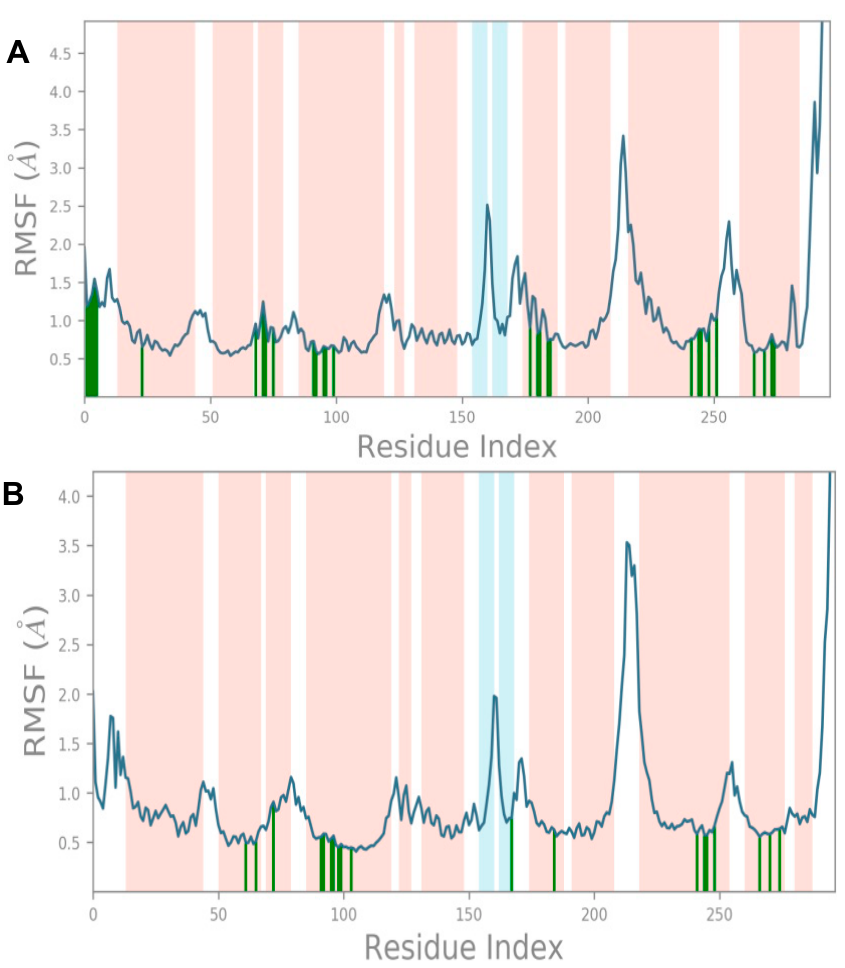
Figure 6. ( A ) The protein RMSF plot for etazene and ( B ) M6 with MOR complex (PDB ID: 5C1M) relative to the reference frame at 0 ns. The green-colored vertical bars on the bottom of the plot represent protein residues that have interacted with the ligand.